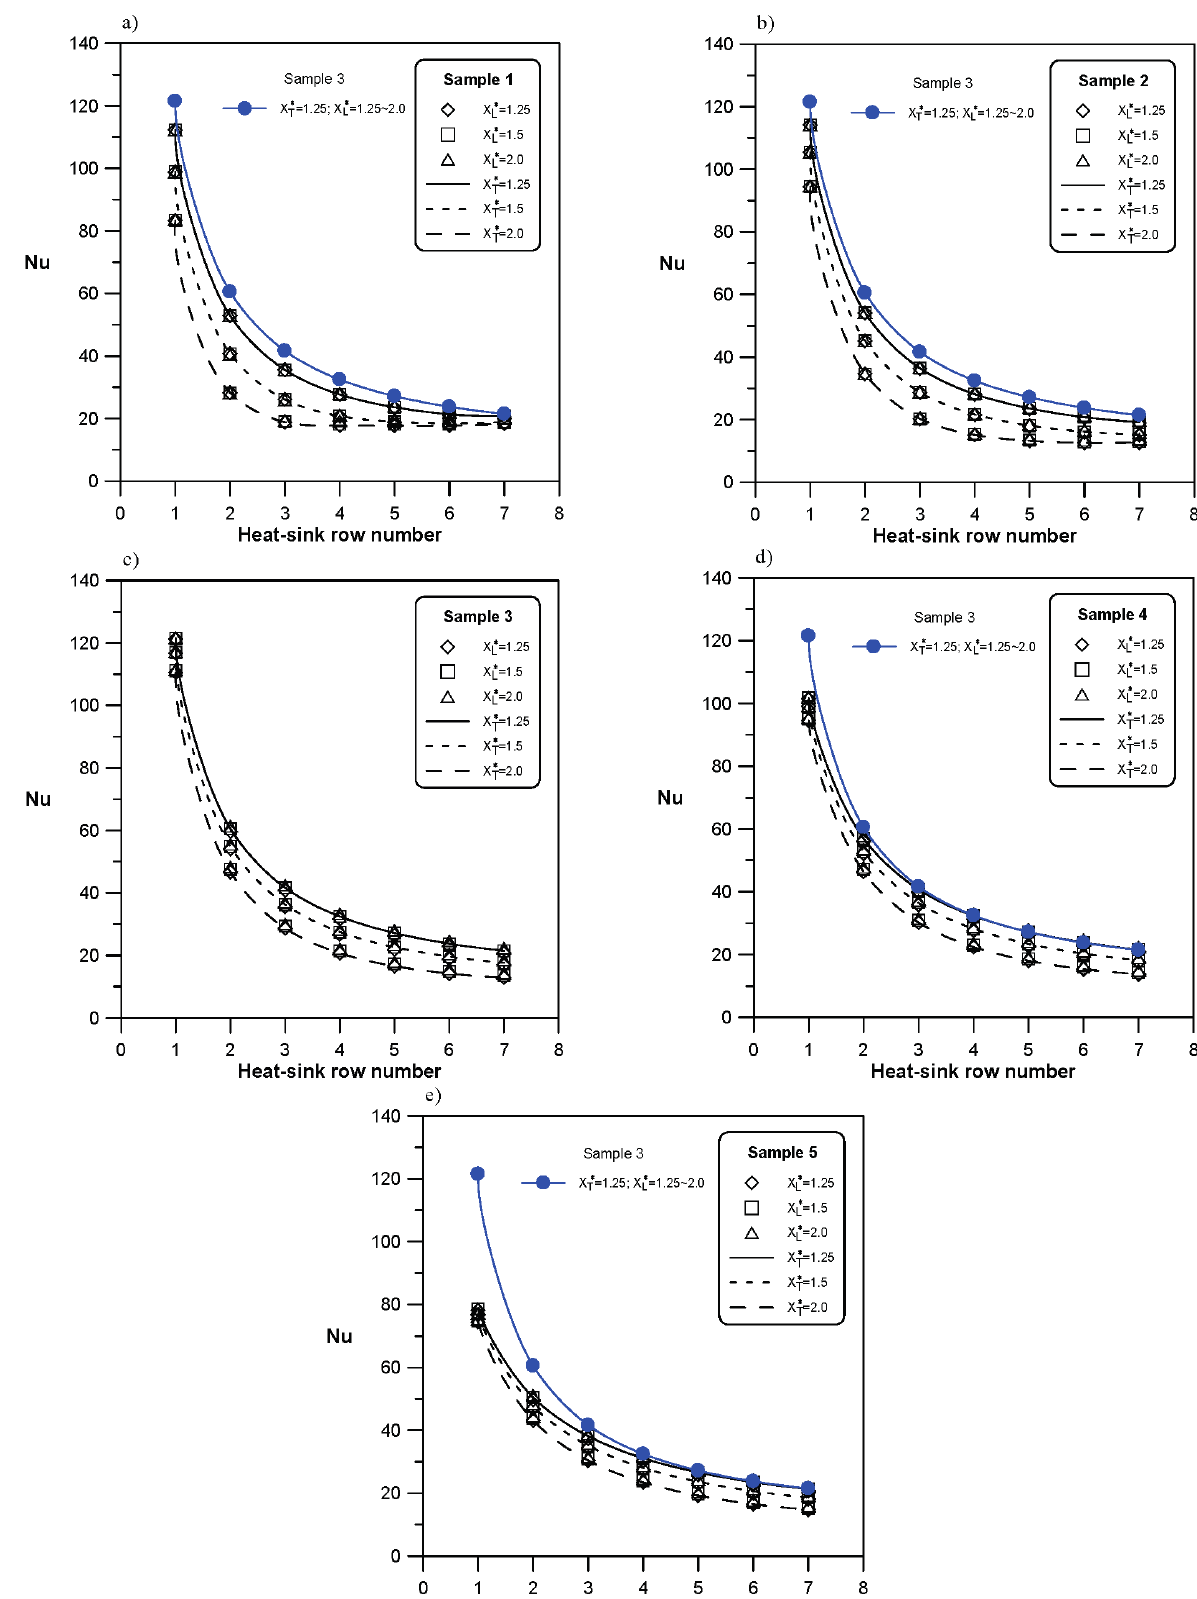
Figure 14. Nusselt number distributions along the main stream direction for various heat-sink arrays: ( a ) Sample 1; ( b ) Sample 2; ( c ) Sample 3; ( d ) Sample 4; and ( e ) Sample